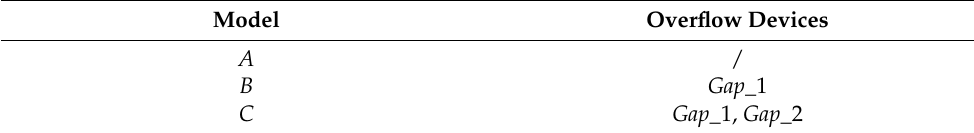
Table 2. Calculation